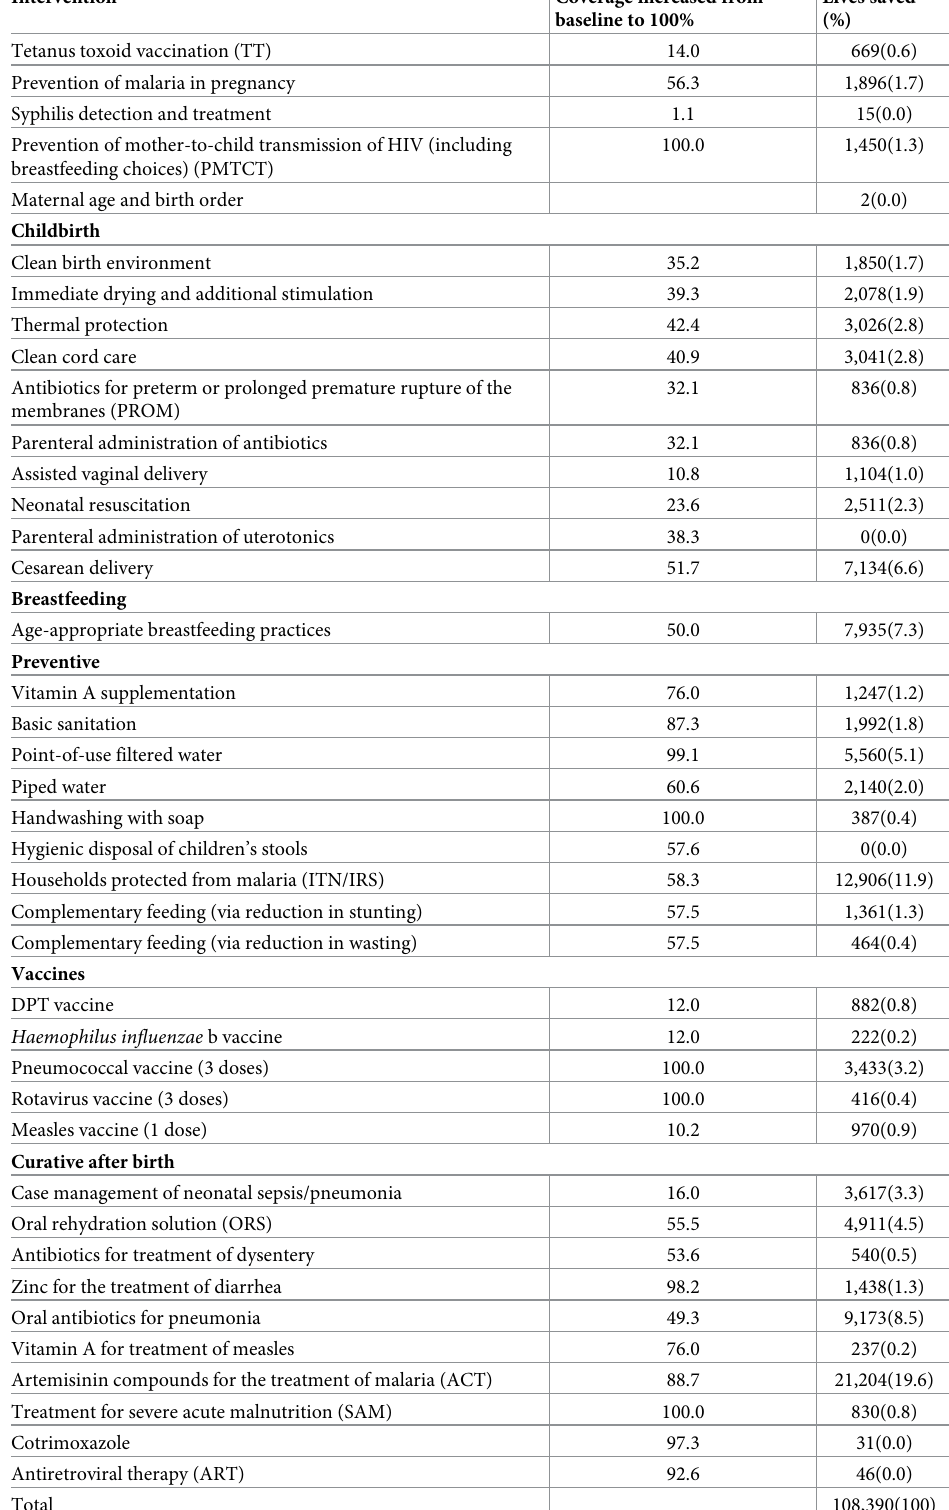
Table 3. Additional child lives saved by intervention in 2014 intervention coverage levels were scale-up to 100% among children 0–59 months.